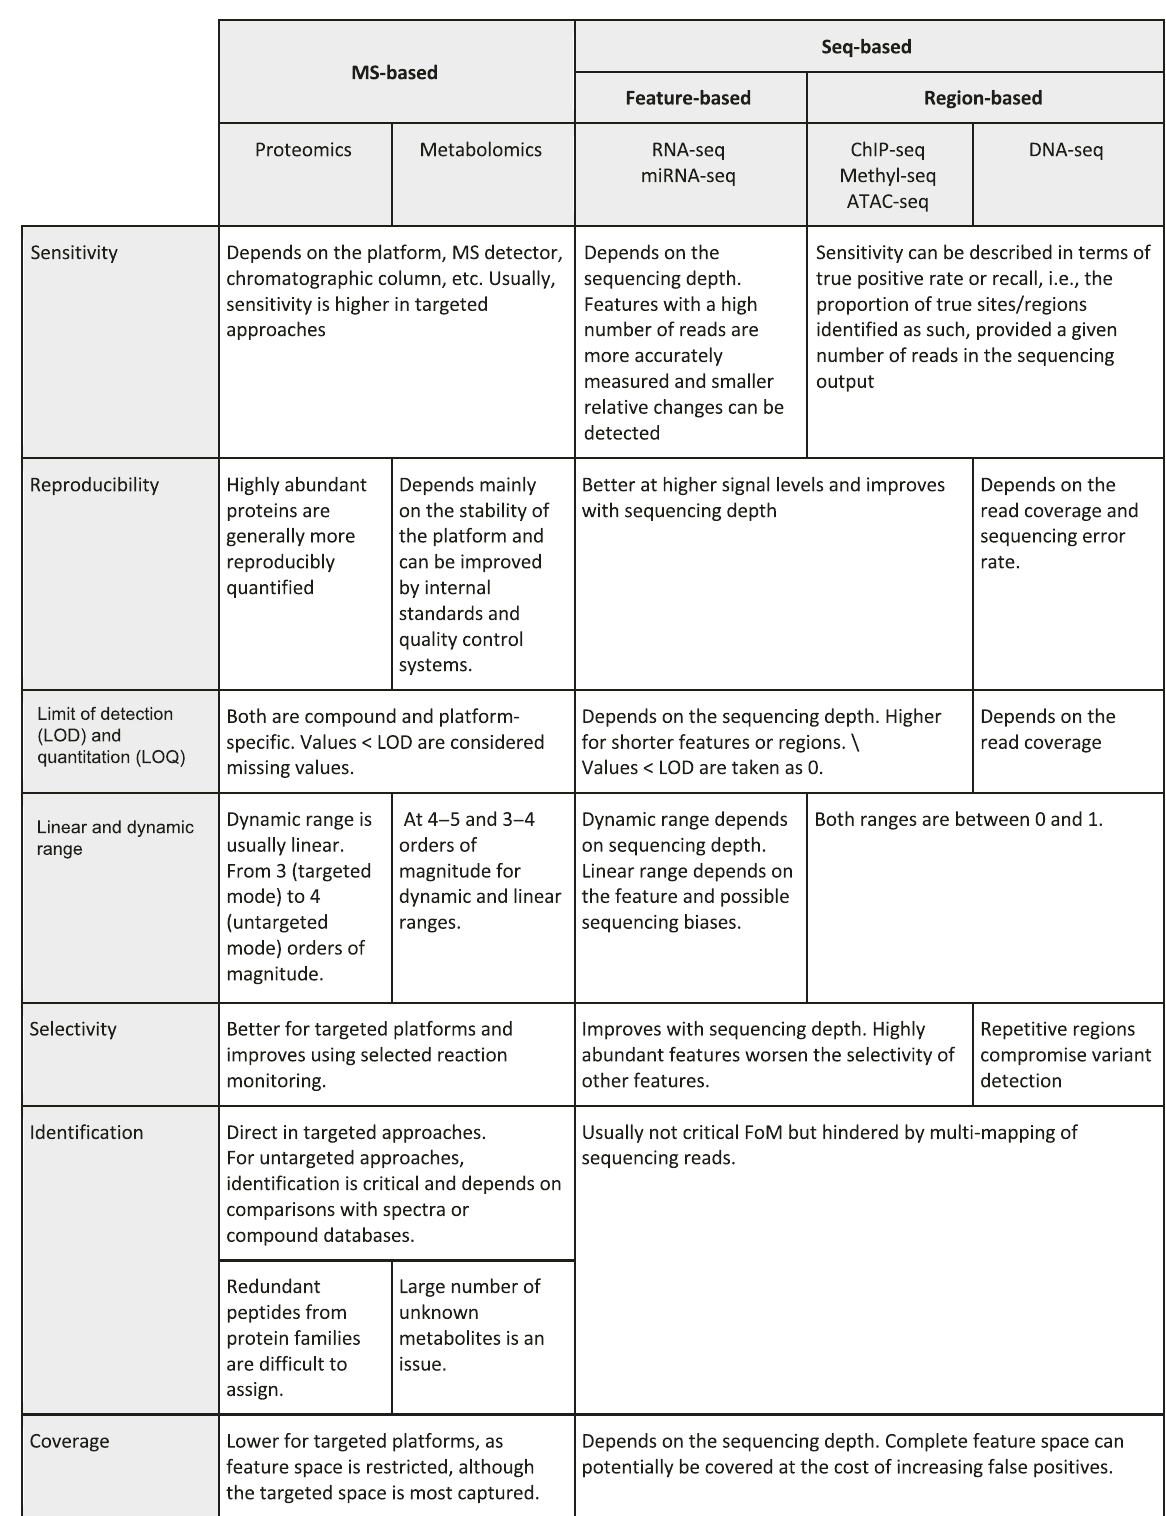
Fig. 2 FoM across omic platforms. The table summarizes critical aspects of each FoM and